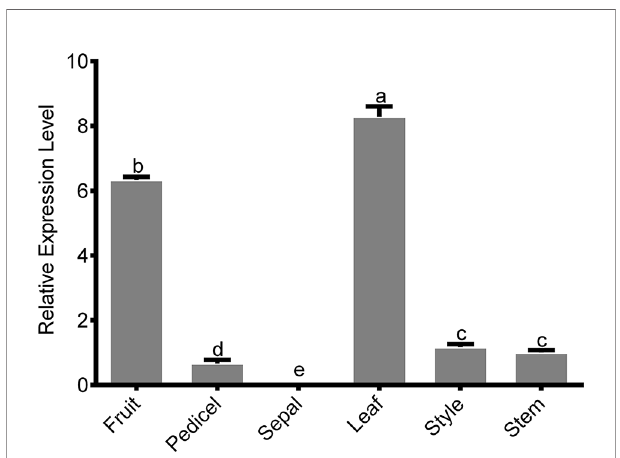
FIGURE 2 | Tissue-speci fi c expression of PbGA20ox2 . A qRT-PCR analysis was used to determine the relative expression level of PbGA20ox2 in various tissues and organs. Values shown are means ± SD ( n = 3). Signi fi cant differences ( P < 0.05) among different tissues as determined by Duncan's test are indicated using different lowercase